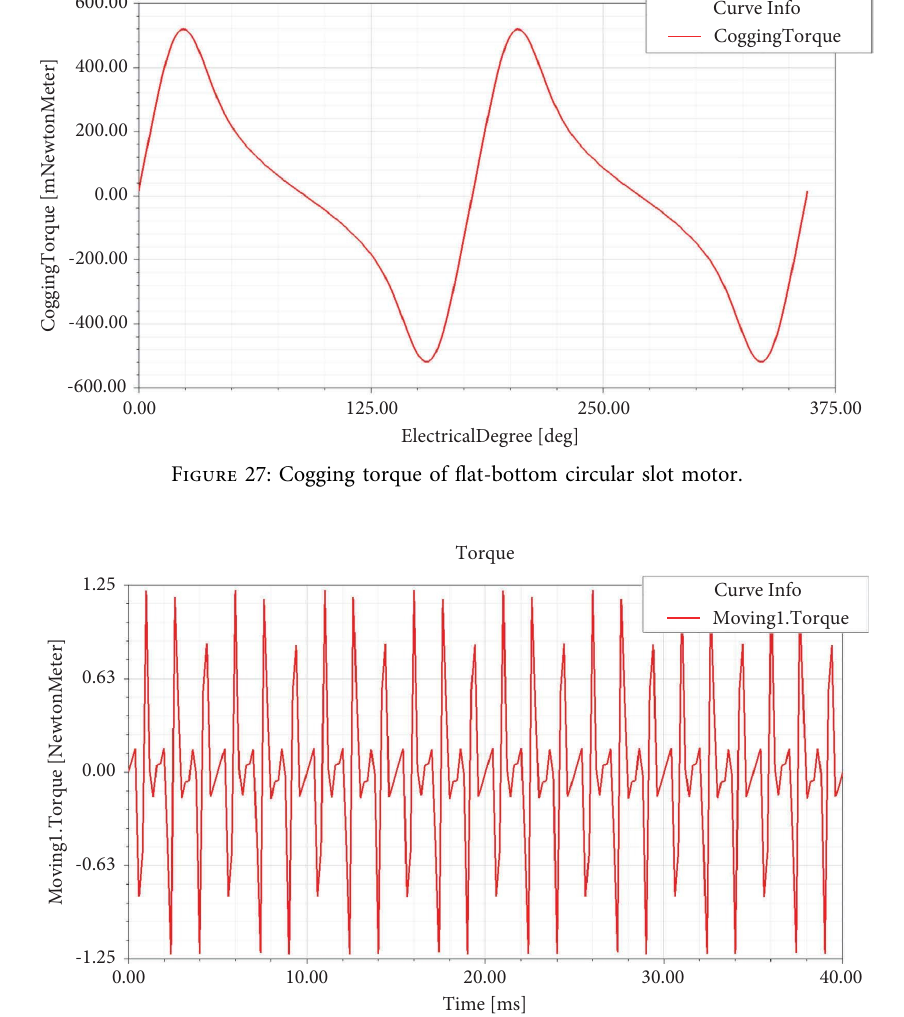
Figure 28: Magnetic resistance torque curve of pear-shaped ladder slot motor.